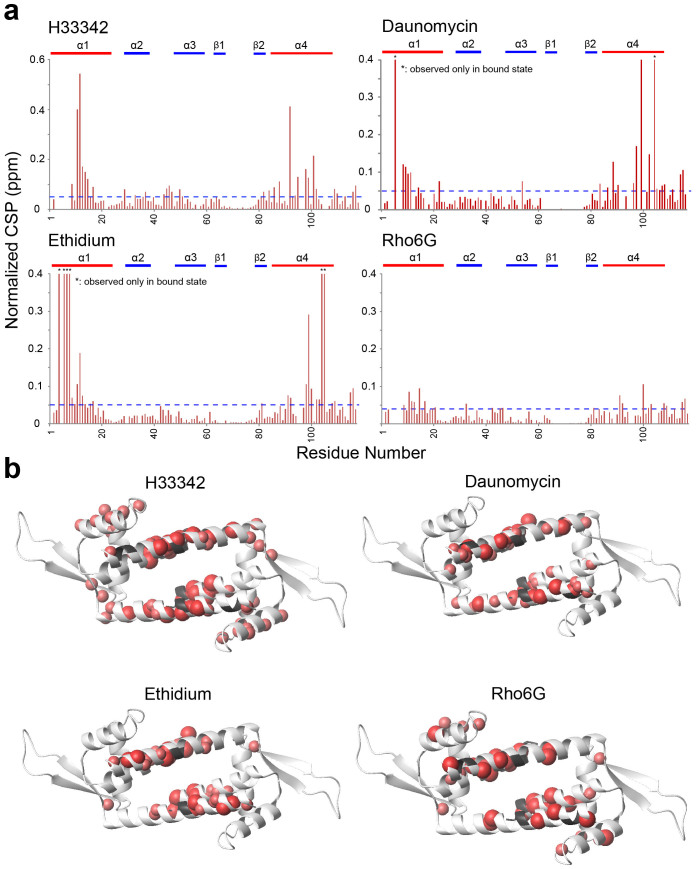
CSPs of mainchain amide resonances of LmrR upon binding to compounds.H33342, daunomycin, ethidium, and Rho6G were added at the indicated concentrations. (a), Plot of the magnitudes of the normalized chemical shift change for each residue. The resonances that were only observable in the compound-bound states are indicated with asterisks. (b), Mapping of significantly perturbed (>0.05 ppm) residues on the ribbon representation of LmrR. Residues that were not observed in each bound state are shown in black.